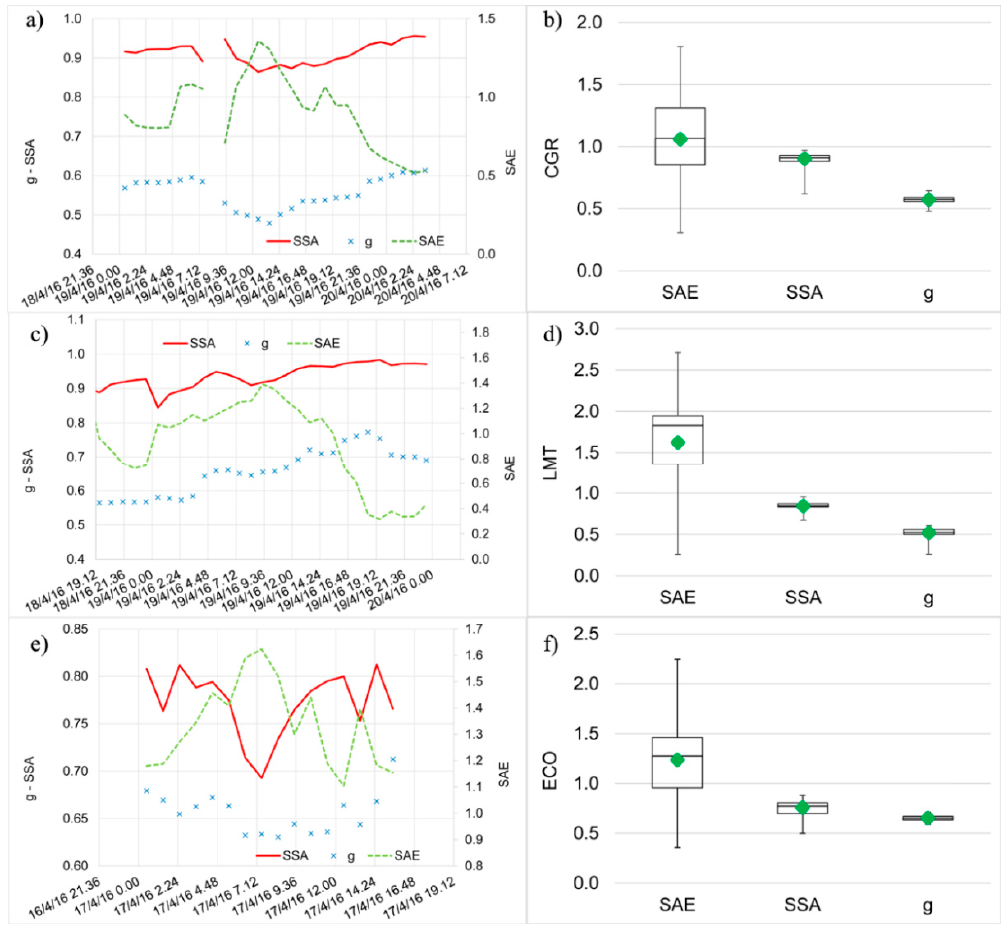
Figure 8. A time example for SAE, SSA, and g for an anthropic episodes at ( a ) CGR, ( c ) LMT, and ( e ) ECO observatory, respectively. Box and whiskers plots for SAE, SSA, and g for anthropic contribution selection at ( b ) CGR, ( d ) LMT and ( f ) ECO observatory, respectively. Horizontal black lines are the median value. Boxes represent the 25th and 75th percentiles. Whiskers are min and max values. In green (diamond) are the average values for the three measured parameters.